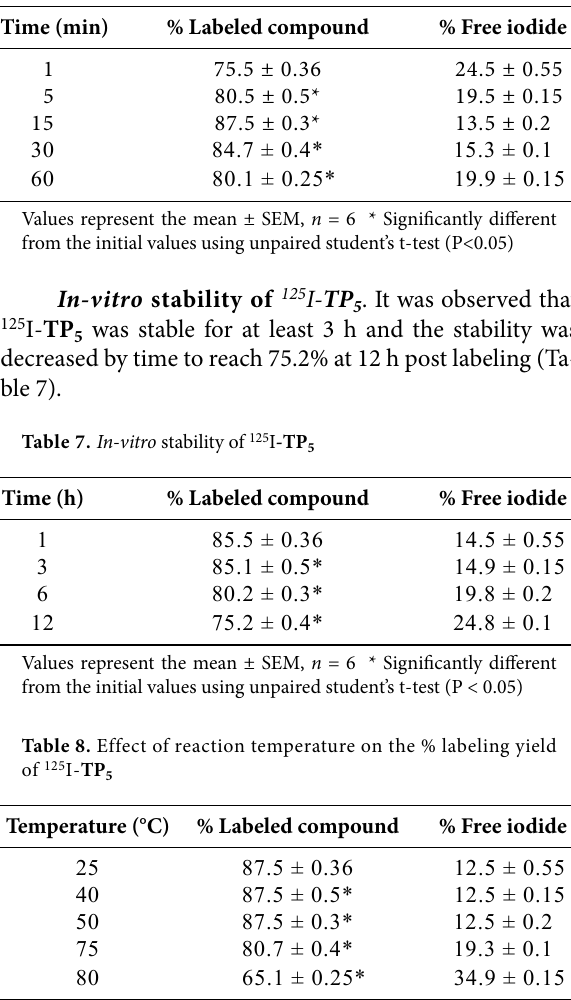
Table 6. Effect of reaction time on the % labeling yield of 125 I- TP 5